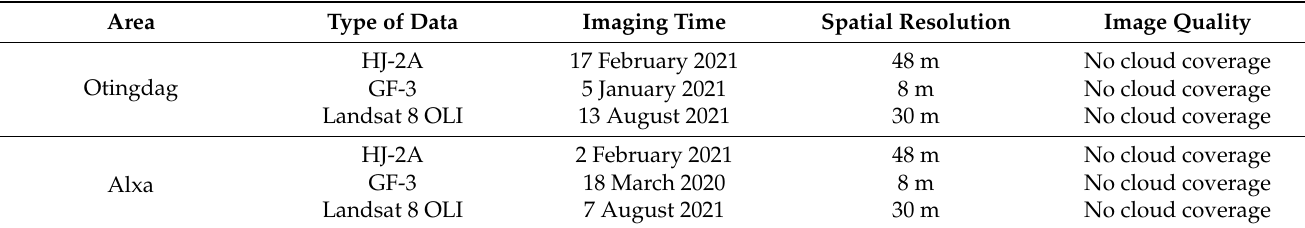
Table 1. Remote sensing data information.